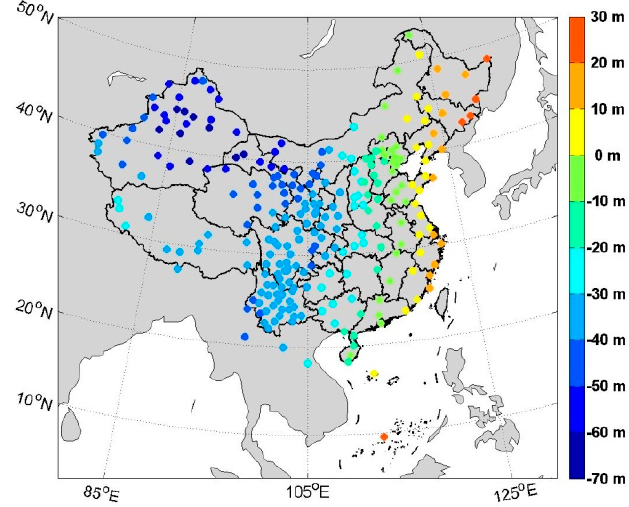
Figure 2. EGM2008 model’s geoid undulations of CMONOC GNSS sites.